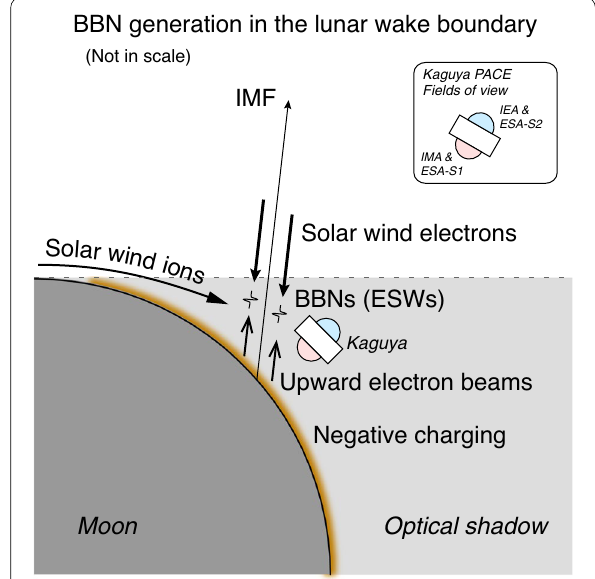
Fig. 5 A schematic picture of possible ESW excitation in the wake boundary of the near-Moon region. The lunar wake in the northern hemisphere is drawn. Fields of view of PACE sensors are also illustrated (see Saito et al. (2010) for the detailed and precise